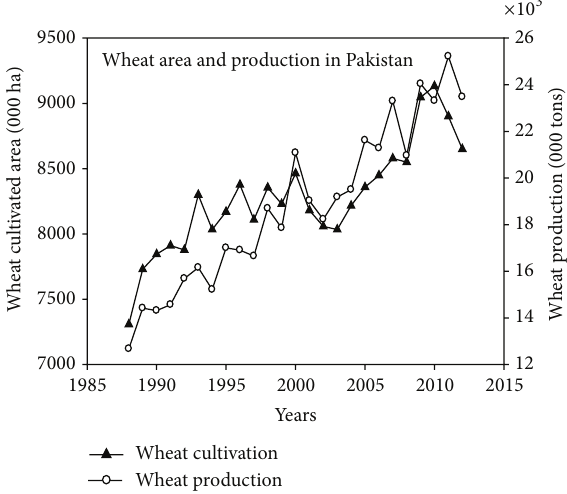
Figure 1: Historical wheat cultivation and production in Pakistan from 1988 to 2012.